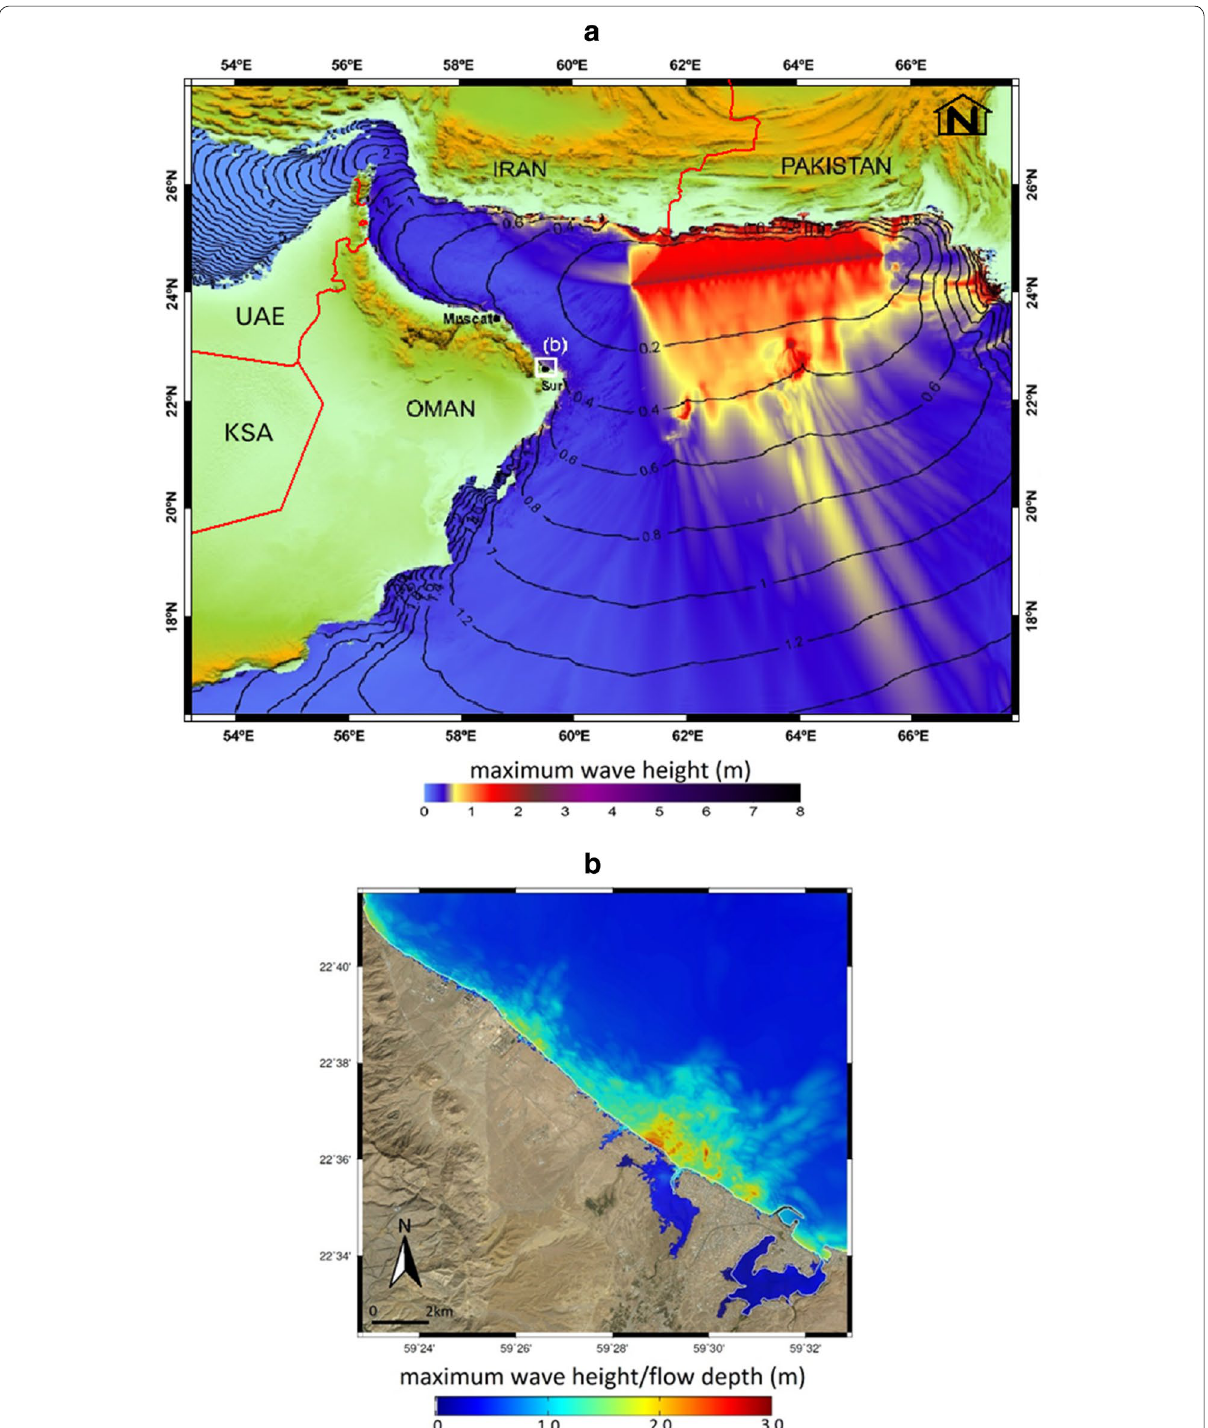
Fig. 4 a Maximum wave height distribution in the Arabian Sea following the occurrence of a Mw 8.8 earthquake event in the eastern segment of the MSZ. The contours represent the tsunami travel time in hours and plotted every 0.2 h; b maximum wave height and maximum flow depth distribution along the coastal segment Sur due to the occurrence of a Mw 8.8 earthquake